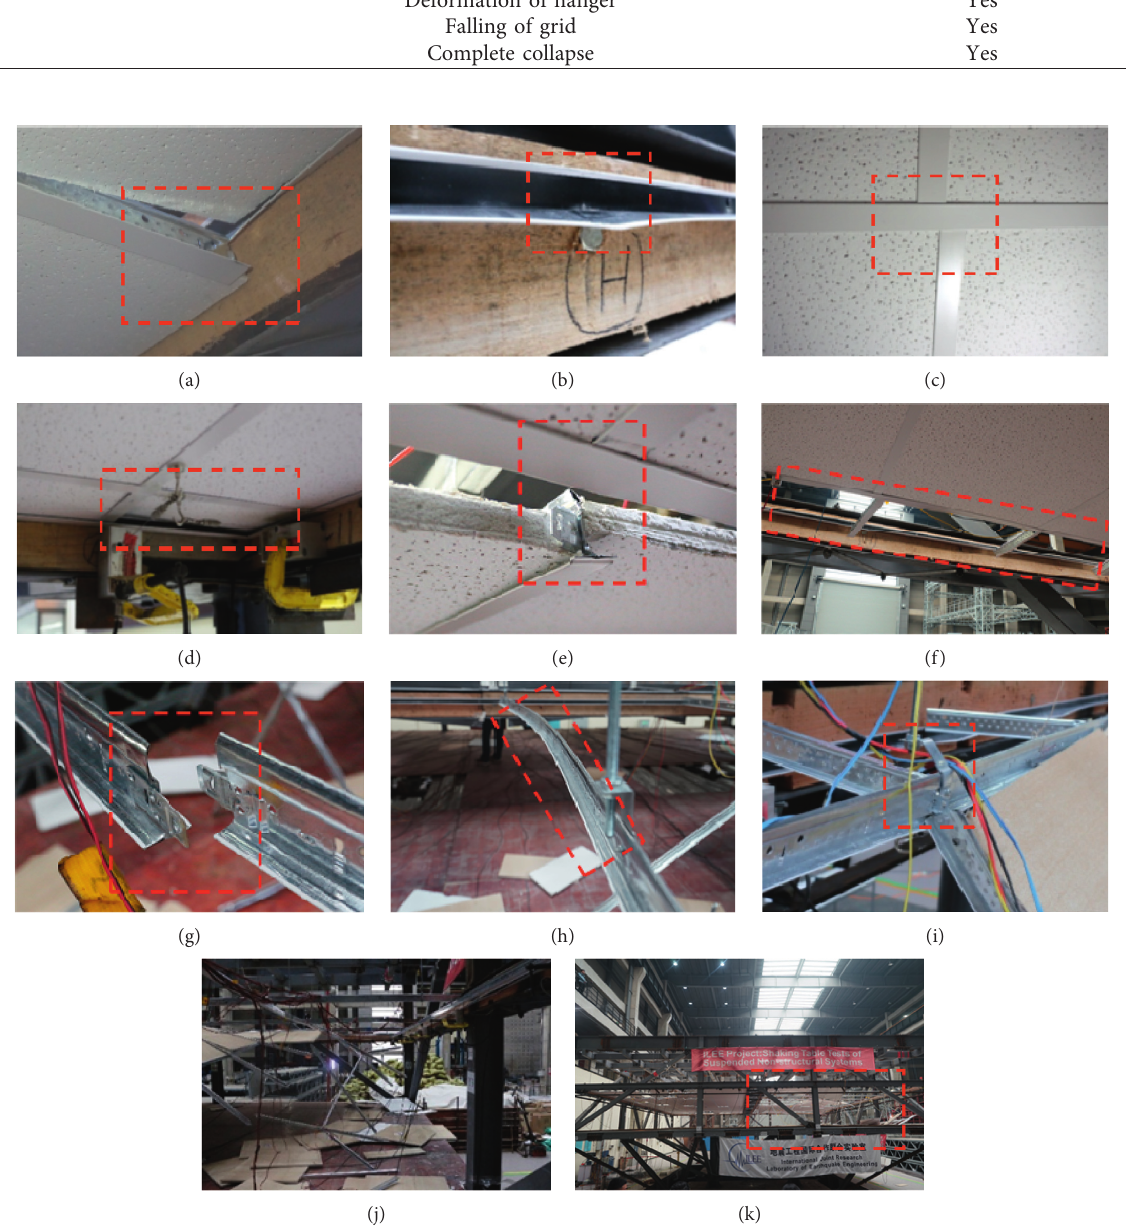
Figure 12: Typical damage to the specimen. (a) Unseating of grid, (b) buckling of wall angle, (c) axial buckling or shear deformation of main-cross tee connection, (d) dislodgement of panel, (e) separation of main-cross tee connection, (f) falling of panel, (g) separation of main tee connection, (h) buckling of grid, (i) large deformation of hanger, (j) falling of grid, and (k) complete collapse. Note: the damage modes of axial buckling and shear deformation of main-cross tee connection are basically